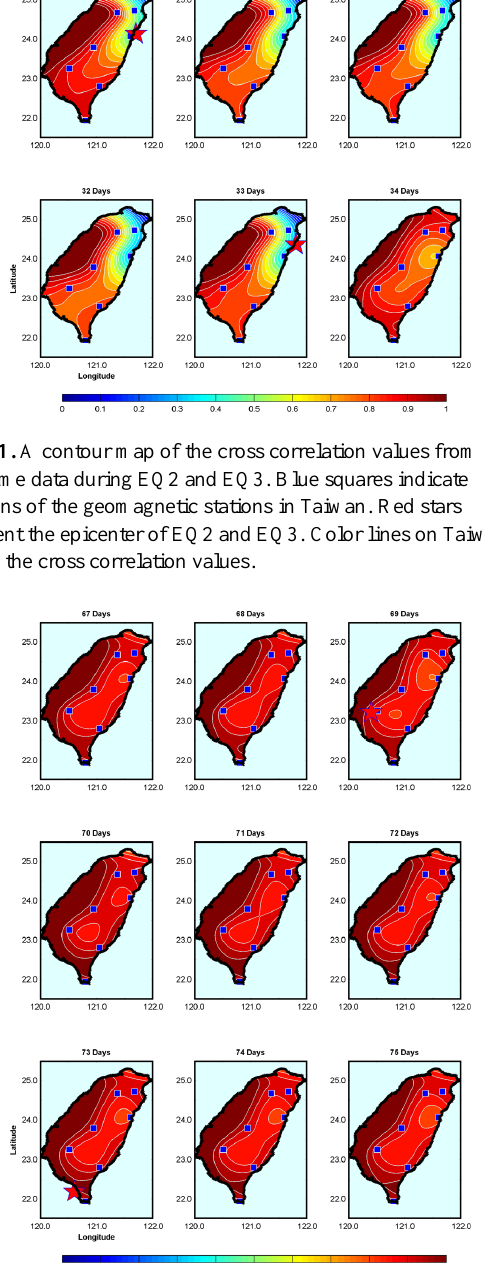
Fig. A2. A contour map of the cross correlation values from nighttime data during EQ4 and EQ5 (the red stars).